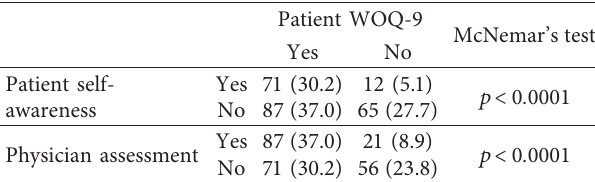
Table 5: Differences in the assessment of WO between patient self- awareness and physician assessment based on patient’s